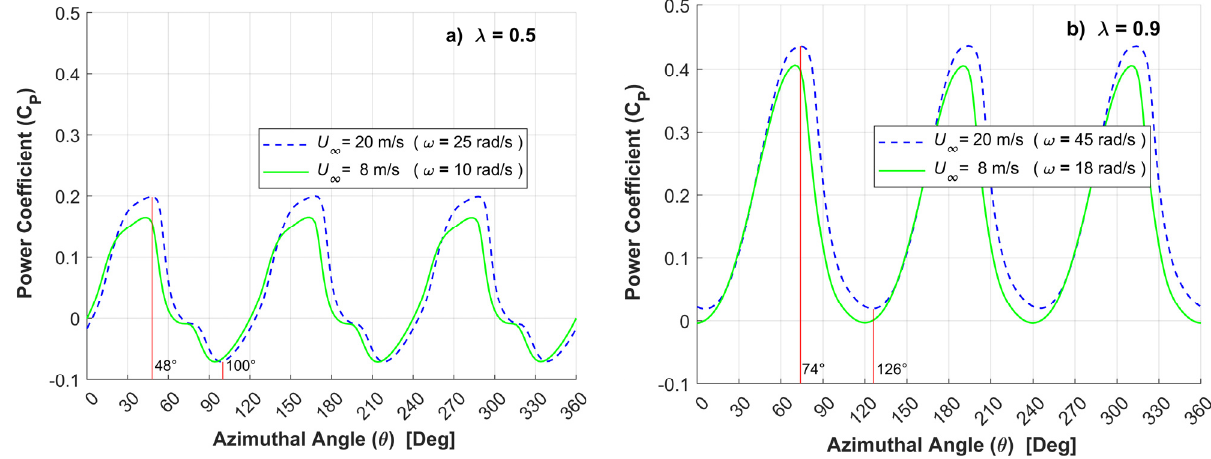
Figure 15. Power Coefficient Changes with Azimuthal Angles for U ∞ = 8 m/s and U ∞ = 20 m/s at: ( a ) λ = 0.5 and ( b ) λ = 0.9, Using the 2D Model of the Present Study. According to (3), it is apparent that the maximum value of C p is obtained at a maximum overall torque ( T ). This occurs at azimuthal angles ( θ ) that are close to those of the torque peak values for each one of the blades. In the case of the main blade, when U ∞ = 8 m/s, the azimuthal angles for the maximum C p were θ = 48 ◦ and θ = 74 ◦ at λ = 0.5 as at λ = 0.9. Torque peak values were obtained at θ = 46 ◦ and θ = 72 ◦ , respectively. Similar behavior was observed for U ∞ = 20 m/s.